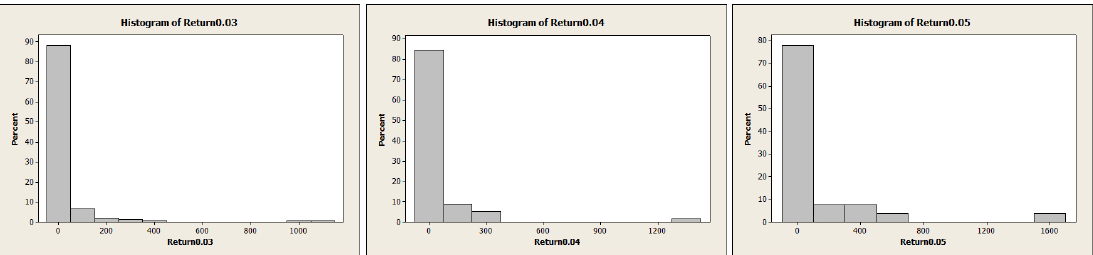
Figure 5. Histogram of waiting time.